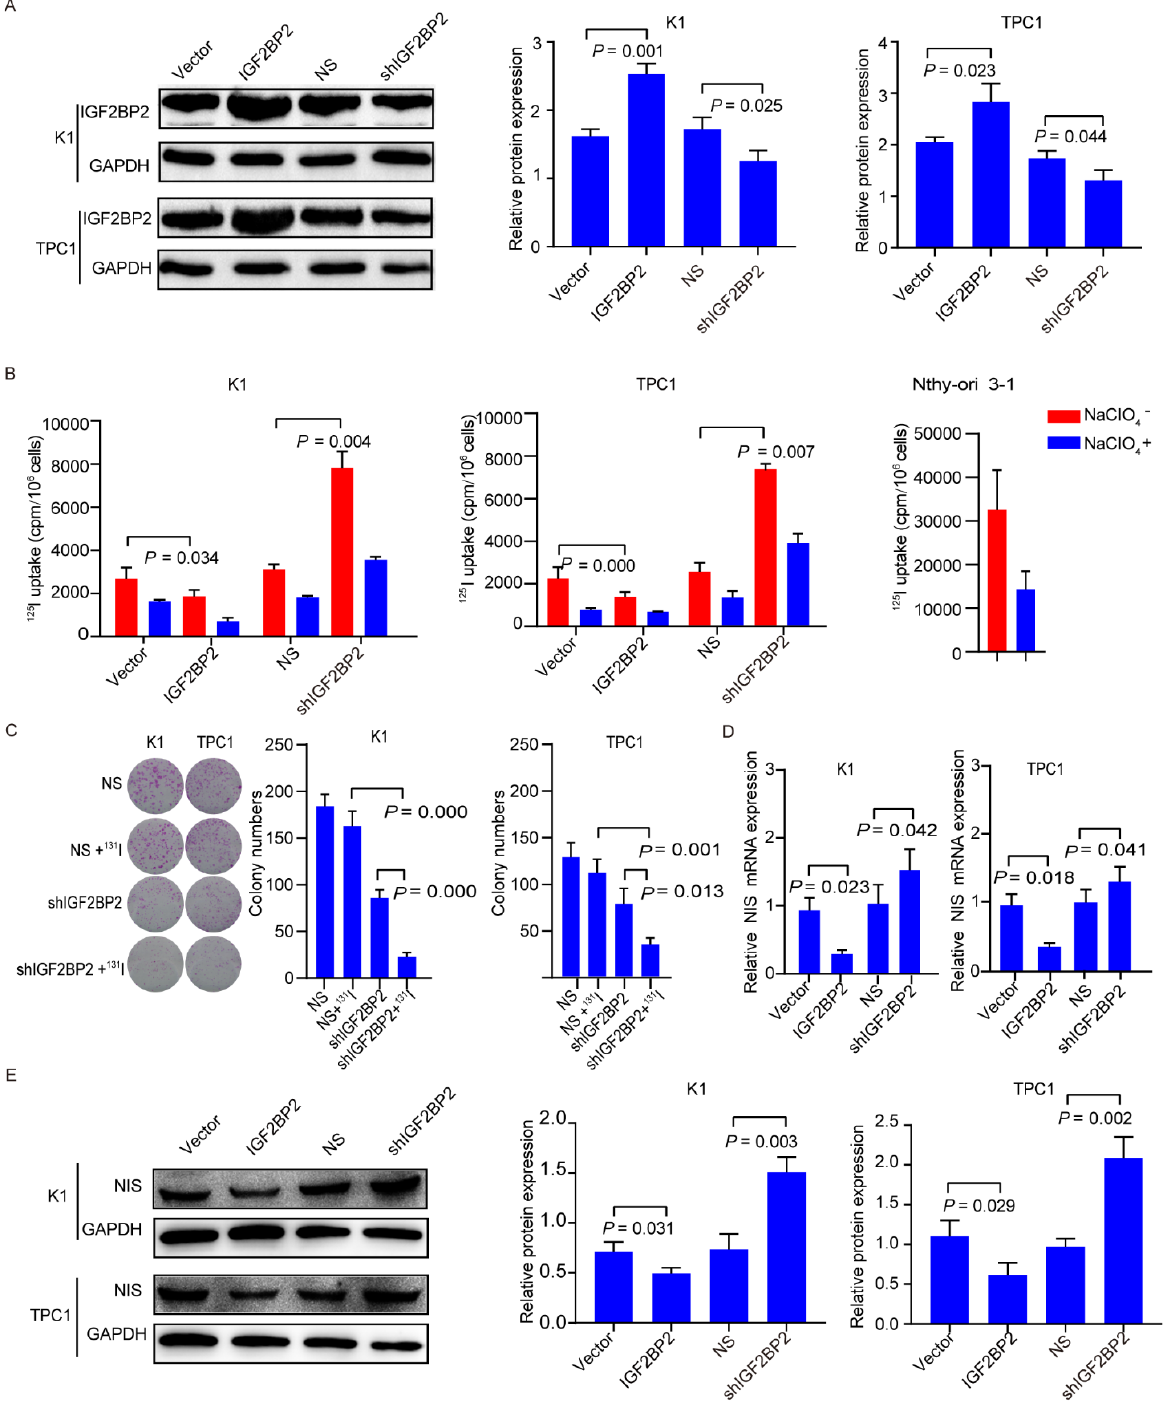
Figure 3. Targeting IGF2BP2 promotes differentiation of PTC. ( A ) Successful transfection in K1 and TPC1 cells with shIGF2BP2 and IGF2BP2 overexpression demonstrated by Western blot. ( B ) 125 I uptake in K1 and TPC1 cells with or without transfection with IGF2BP2 overexpression or knockdown. ( C ) 131 I clonogenic assay in K1 and TPC1 cells with or without transfection with shIGF2BP2. ( D ) NIS mRNA expression in K1 and TPC1 cells with or without transfection with IGF2BP2 overexpression or knockdown. ( E ) NIS protein expression in K1 and TPC1 cells with or without transfection with IGF2BP2 overexpression or knockdown.